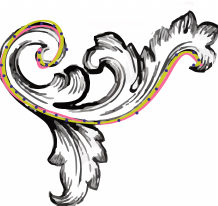
Figure 17. Noisy set of data points obtained from the baroque image (points in blue), fitting curve obtained by training the proposed neural network (points in green) and fitting curve obtained using the regularized least-squares method (pink). Baroque motif image source: